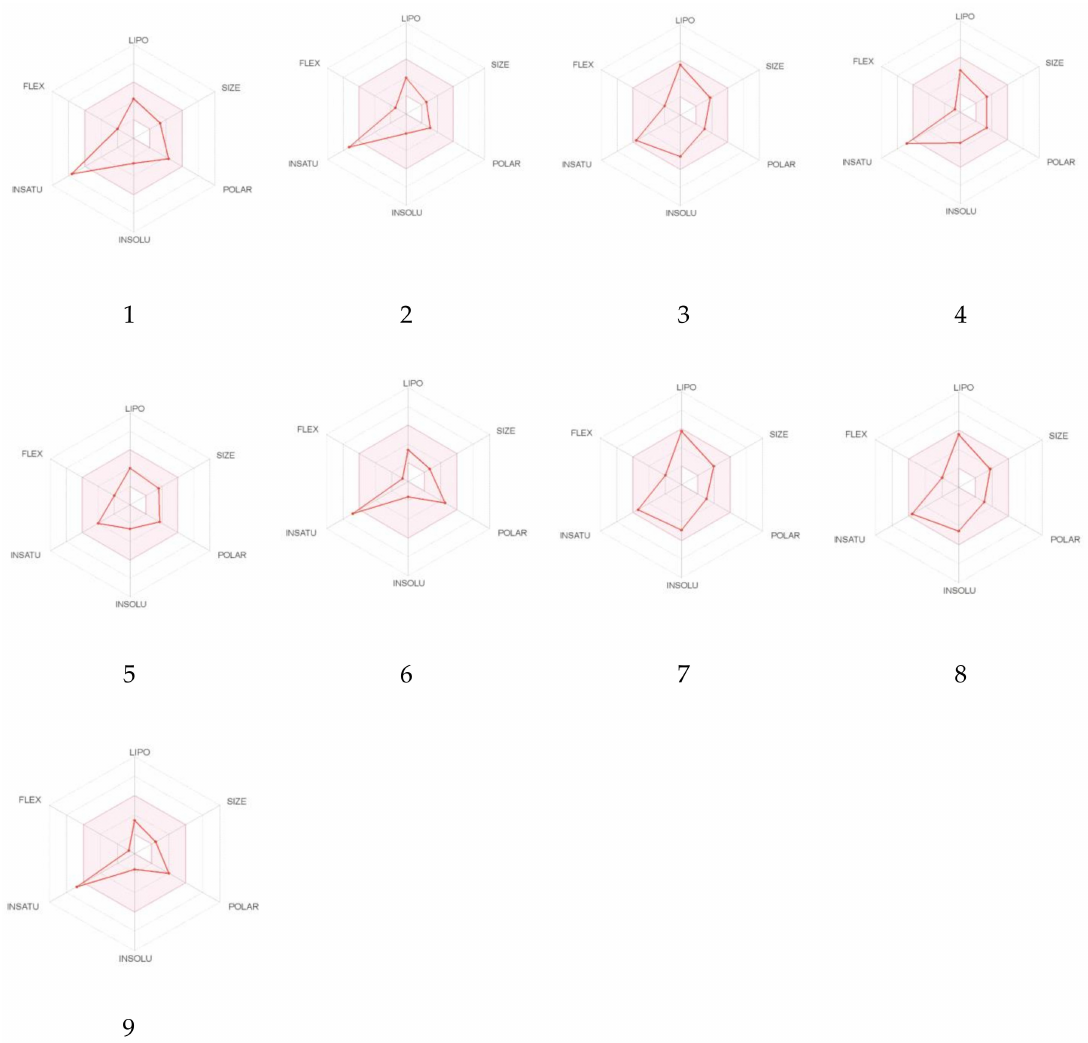
Figure 7. Radar plots of compounds 1–9. The pink area is a suitable physicochemical space for oral bioavailability. Lipophilicity (LIPO): − 0.7 < XLOGP3 < 5.0; SIZE: 150 g / mol < MW < 500 g / mol; polarity (POLAR): 20 Å 2 < topological polar surface area (TPSA) < 130 Å 2 ; and insolubility (INSOLU): 0 < LogS < 6; INSATU (insaturation): 0.25 < fraction of carbons in sp 3 hybridization < 1; FLEX (flexibility): 0 < number of rotatable bonds < 9. The radar plots were obtained using the SwissADME web tool